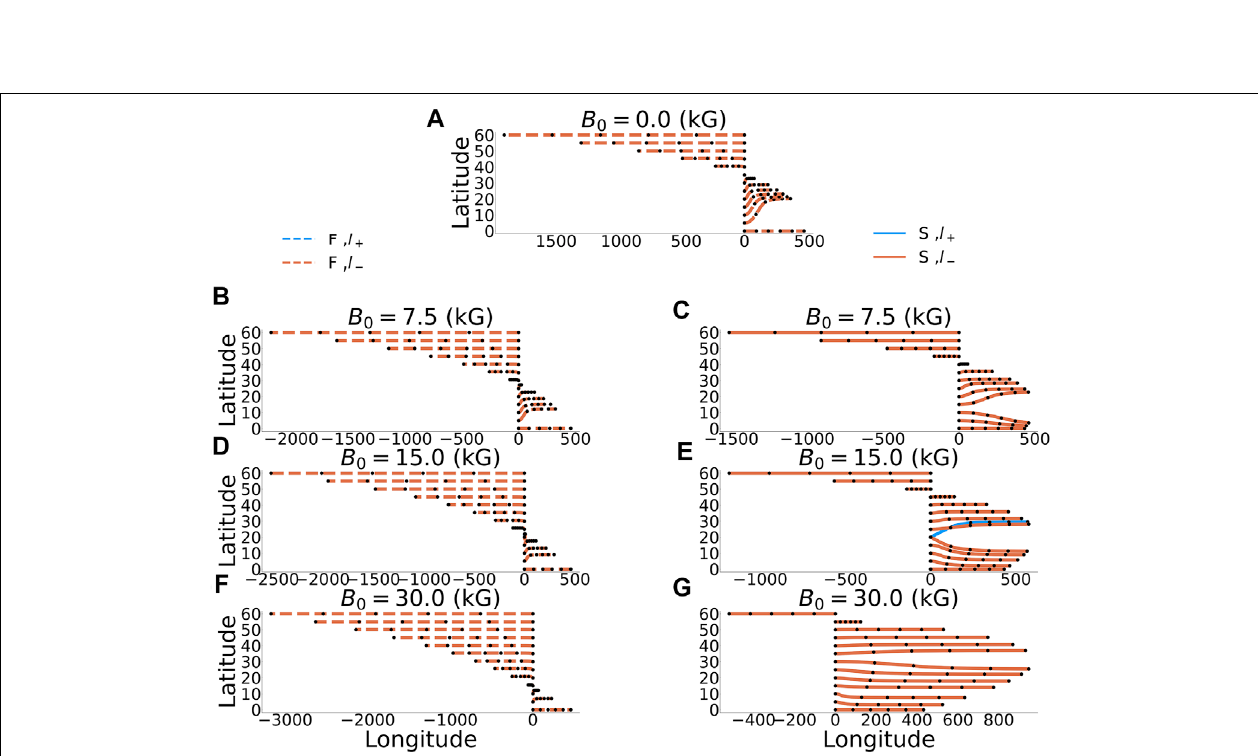
FIGURE 3 | Energy trajectory (initiating at zero degrees of longitude) of the zonal wavenumber-10 wave mode embedded in the broad band toroidal magnetic field, for different initial latitudes. The figures show the trajectories for the magnetic field strengths of 0G (A) , 7.5 kG (B,C) , 15 kG (D,E) and 30 kG (F,G) . The left panels refer to the fast hydrodynamic branch of the dispersion relation, whereas the right panels refer to the corresponding slow magnetic branch dispersion relation. For all the panels, the blue (red) curve refers to the “ + ” (“ − ”) branch of the meridional wavenumber.